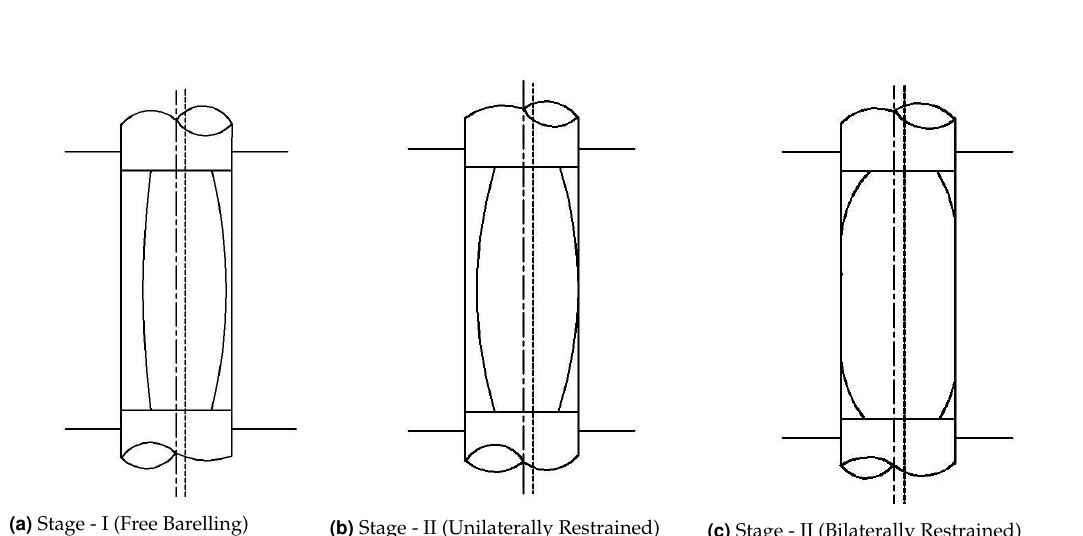
Fig. 3. Deformation Stages during Closed-Die Forging